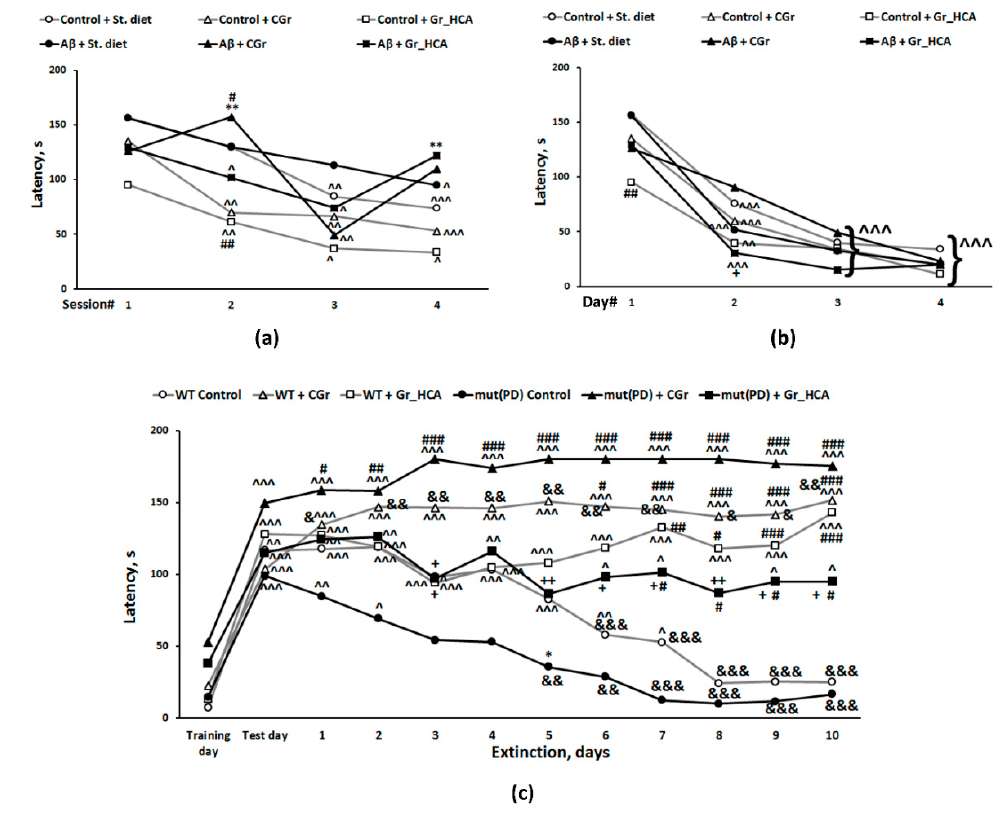
Figure 3. E ff ects of the type of diet and A β 25-35 administration (AD model) on the episodic memory measured during the first day of training ( a ) or long-term spatial memory and learning estimated during four days of training ( b ) in Barnes test, or of the type of diet and overexpression of α -synuclein (genetic PD model) on the contextual memory retrieval and memory extinction evaluated in the passive avoidance test ( c ) in mice. Data are presented as the means of the values obtained in an independent group of animals ( n = 5–12 per group). Statistically significant di ff erences: ˆ p < 0.05, ˆˆ p < 0.01, ˆˆˆ p < 0.001 compared to values of the same group in the first session ( a ), on the first day of training ( b ), on the training day ( c ); & p < 0.05, && p < 0.01, &&& p < 0.001 compared to values of the same group on the test day; * p < 0.05, ** p < 0.01 vs. a respective control (in the experiment with AD model) or wild-type (WT) (in the experiment with PD model) group; # p < 0.05, ## p < 0.01, ### p < 0.001 vs. a respective group given the standard diet (St. diet); + p < 0.05, ++ p < 0.01 vs. a respective group